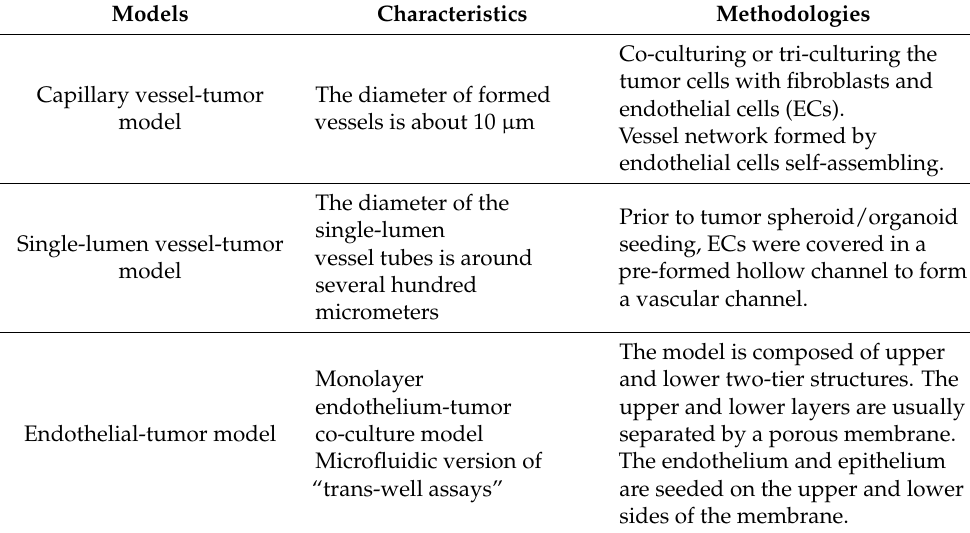
Table 4. Vessel-tumor models based on the size of the vascular tissue. Models Characteristics Methodologies